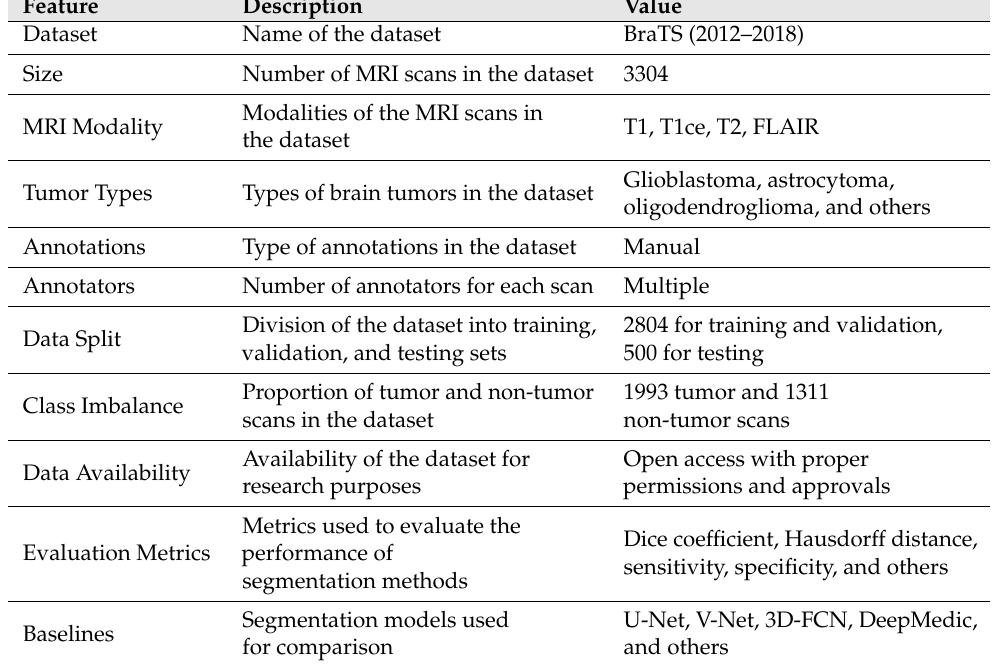
Table 10. Features and descriptions of BraTS datasets